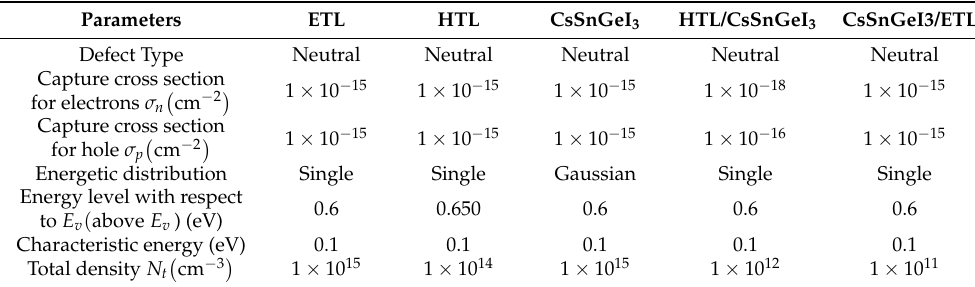
Table 3. Defect density values inside the layers and at interface of the